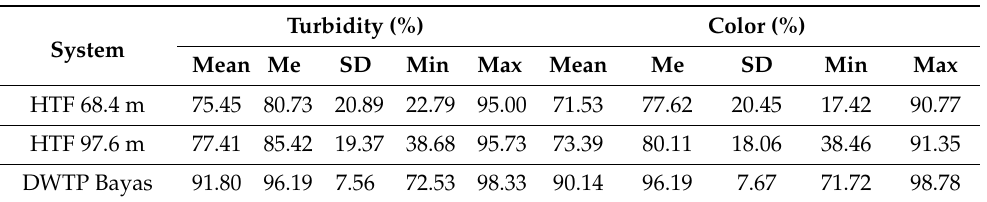
Table 5. Statistical Parameters of the Turbidity and Color Removal Efficiency after HTF + Settler in the Studied Systems.